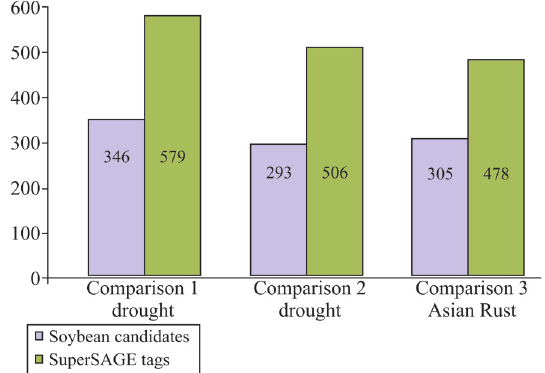
Figure 5 - Number of SuperSAGE tags matching soybean R and PR gene candidates from three different comparisons among the six libraries: 1-Embrapa-48, drought tolerant stressed vs. negative control; 2- BR-16, drought susceptible stressed vs. negative control; 3- PI561356 fungus re- sistant stressed with Phakopsora pachyrhizi vs. negative